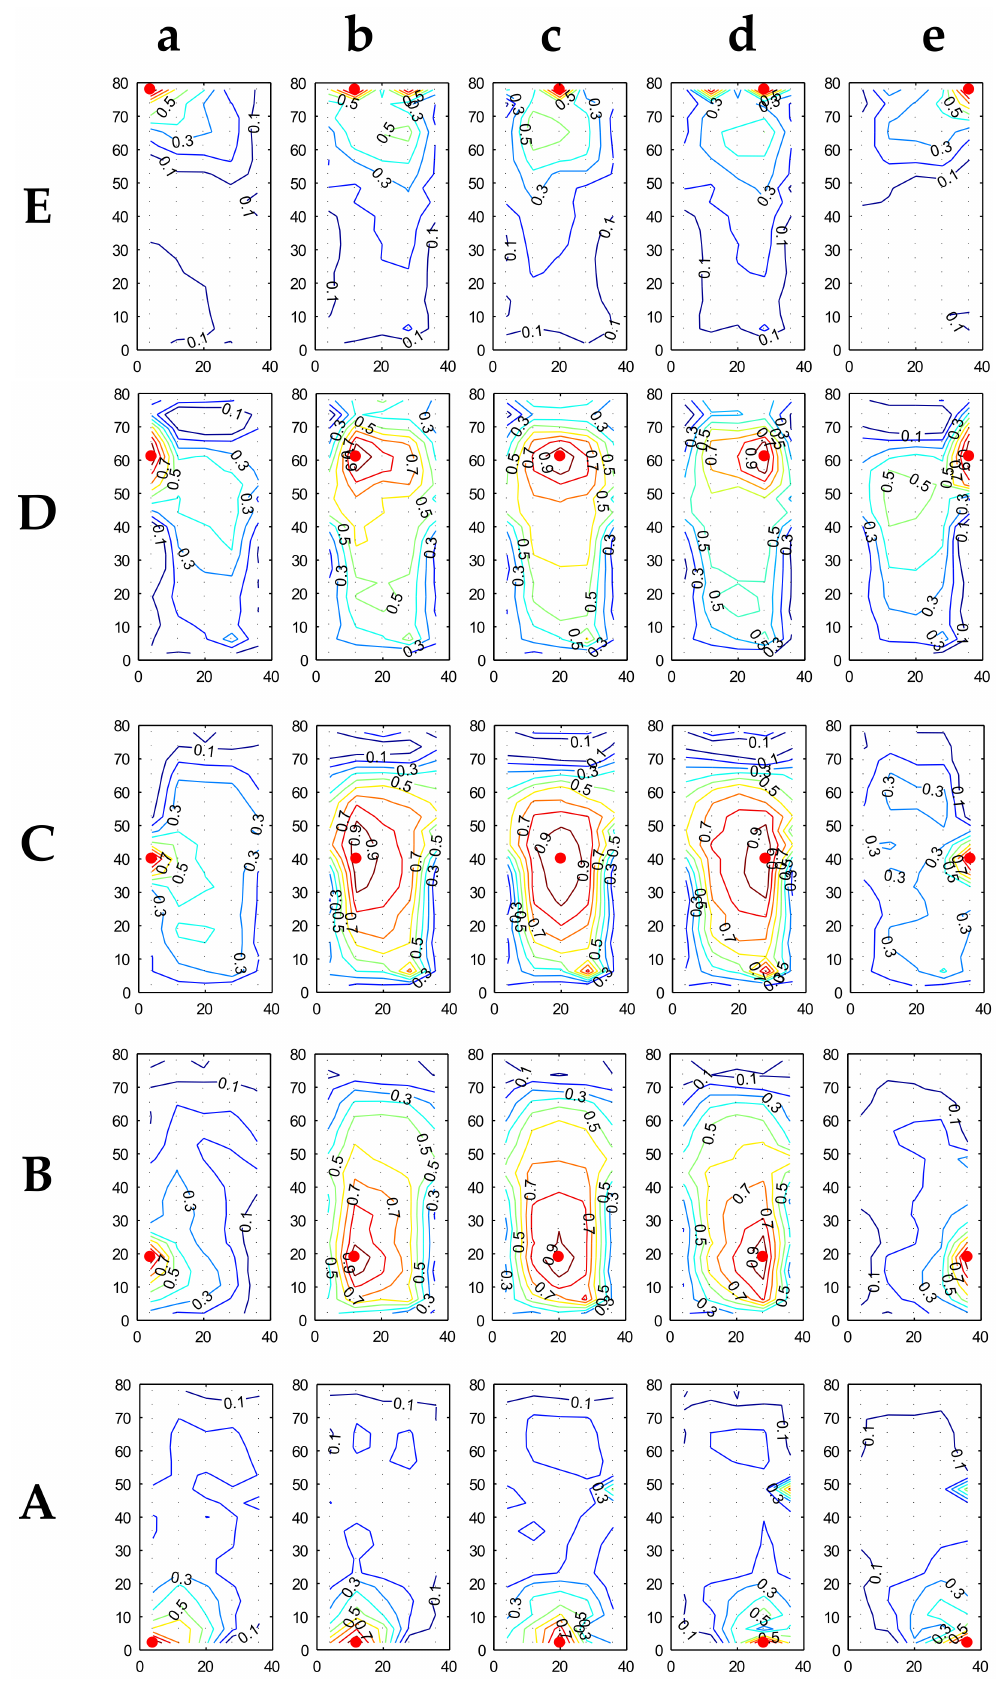
Figure 7. Correlation coefficient trend for RHC at 0 ◦ . Color bar as in Figure